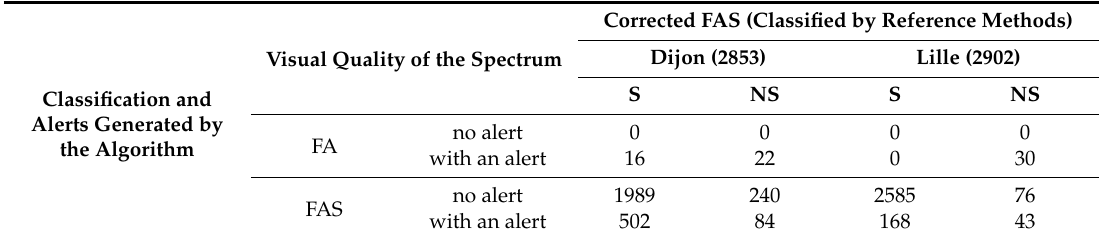
Table 3. Frequency of alert set 2 for FAS samples, according to the analysis facility.